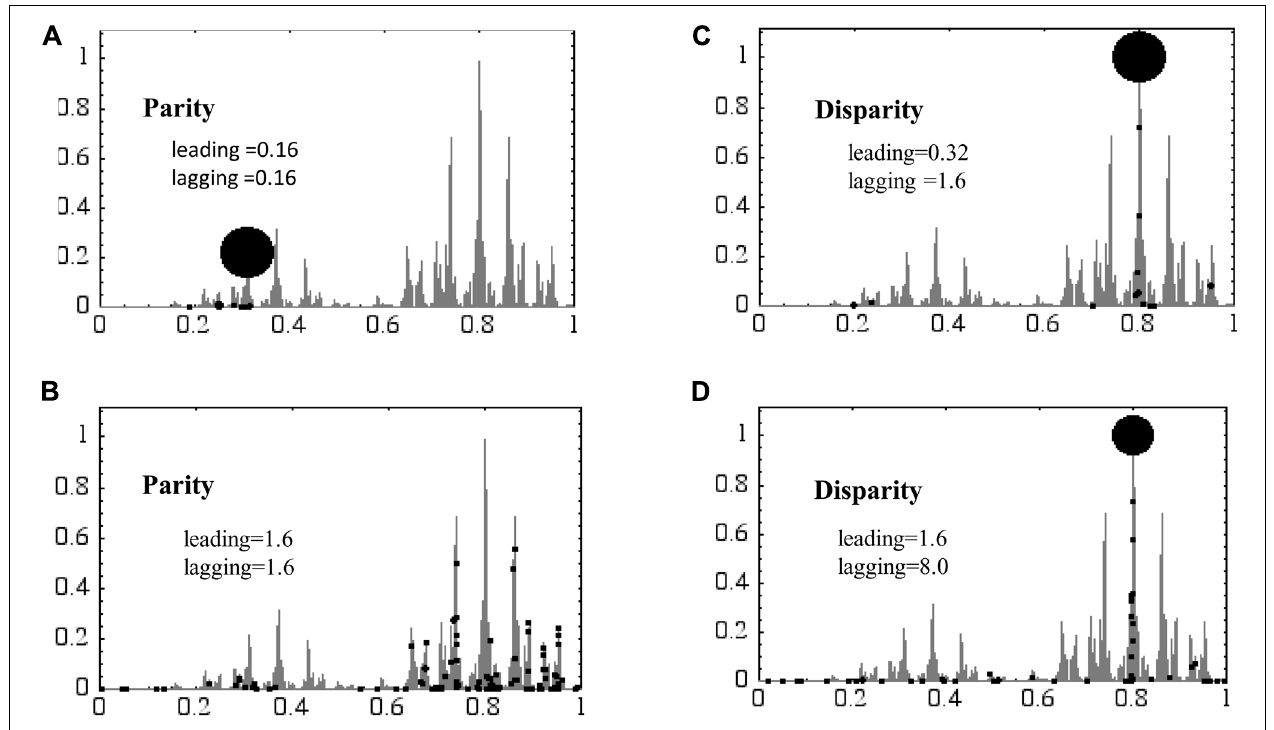
FIGURE 3 |A “hill-climbing problem” is resolved using the parity and disparity “neo-Darwinian genetic algorithm.” The genome of the genetic algorithm consists of 16 bit and replicates using the leading and lagging strands. In parity models mutations are introduced evenly in both strands (A,B) , while in disparity models biased mutations are introduced in the